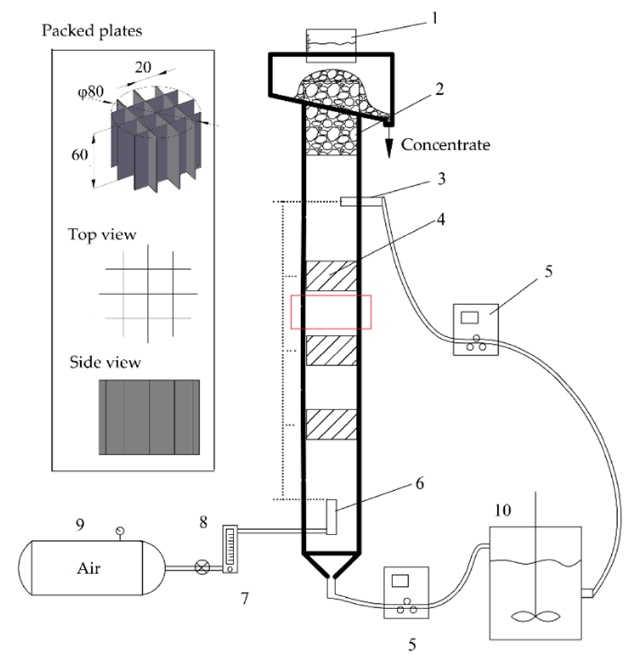
Figure 1. Experiment apparatus used for fine bauxite ore flotation: 1—Washing water device; 2—